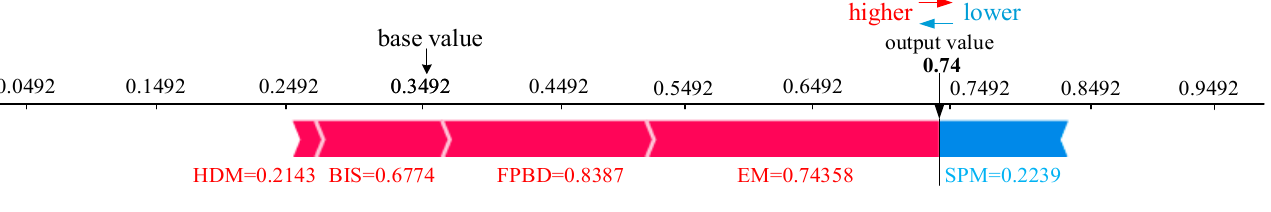
Figure 5. Explanation of the Safety mode.